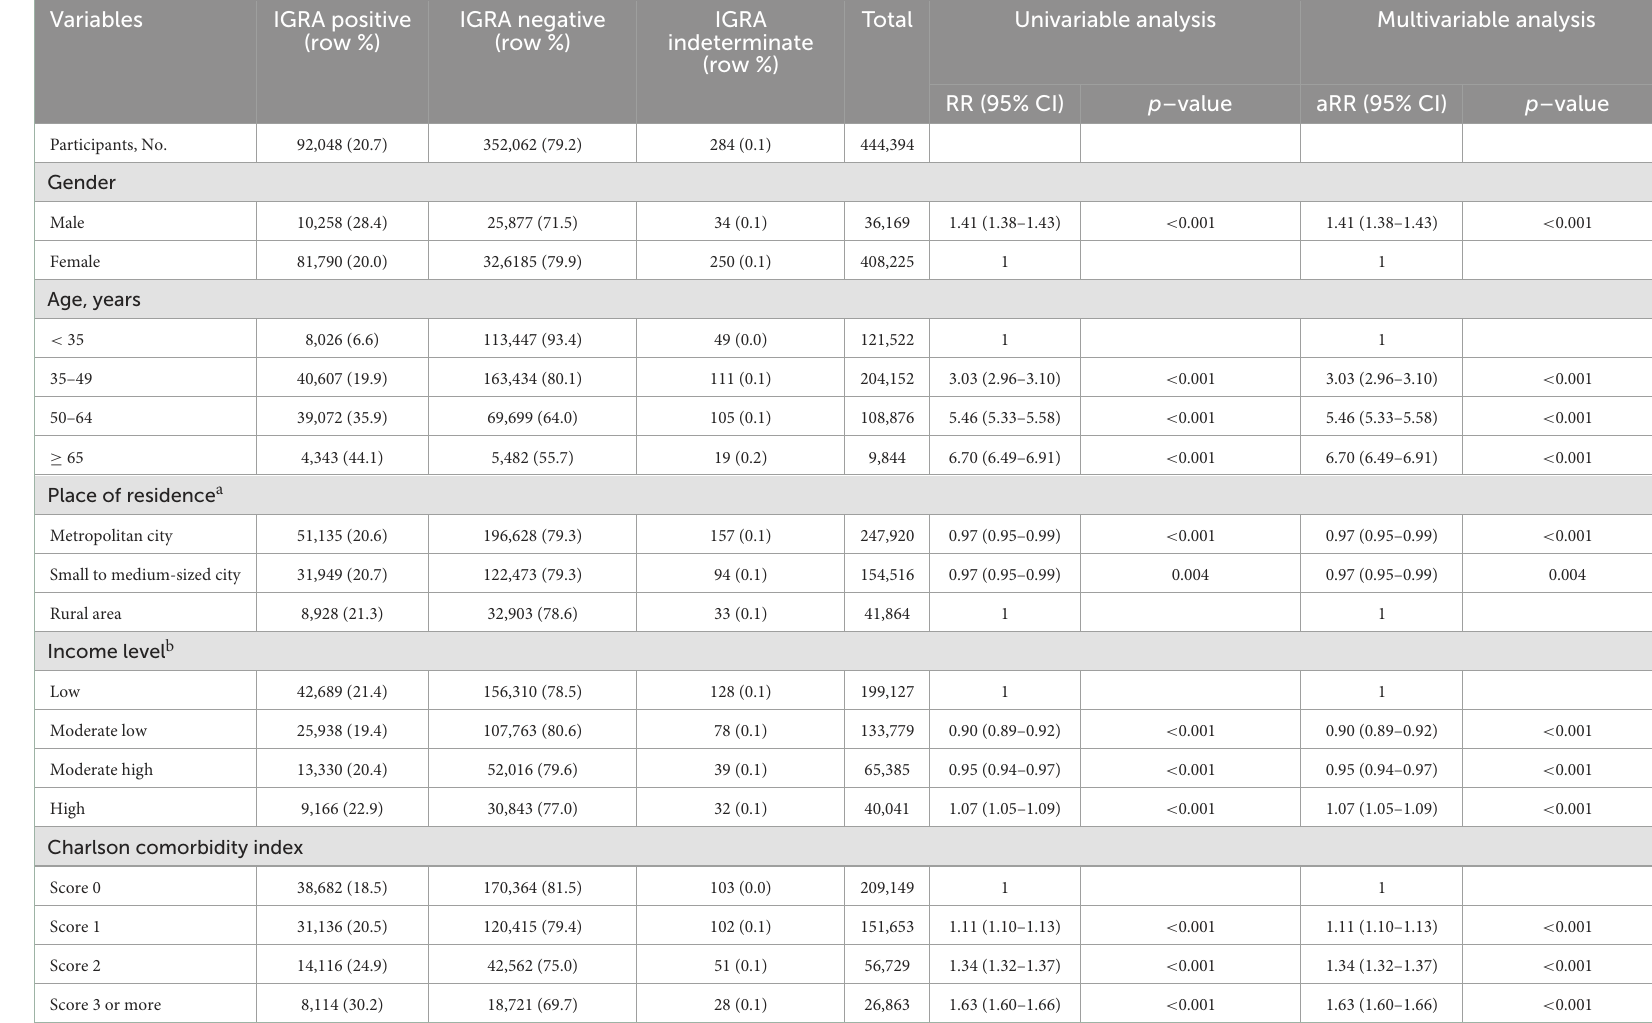
TABLE 2 Prevalence of LTBI in Group A (workers of postpartum care centers, social welfare facilities and educational institutions) and risk factors for LTBI.